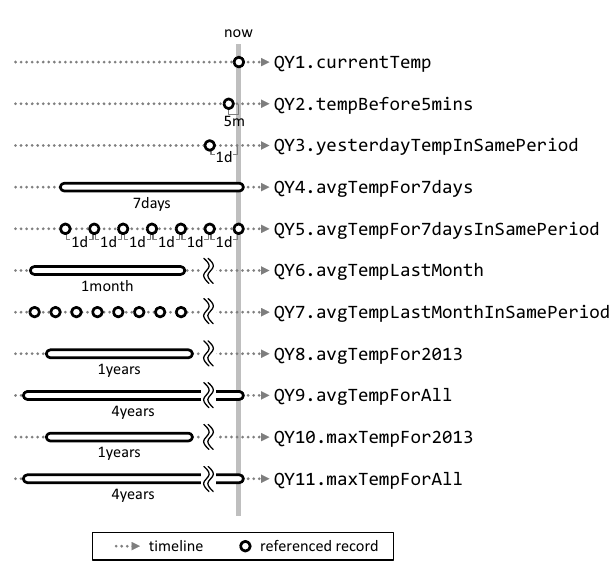
Figure 7. Referenced records of 11 log queries evaluated in